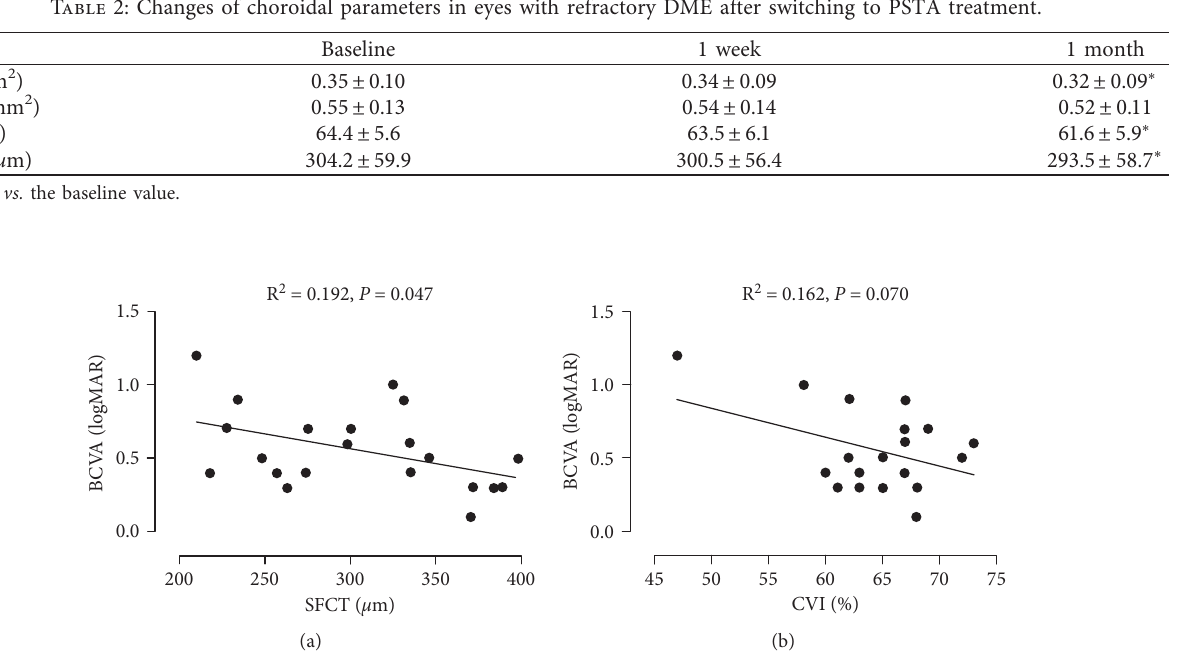
Figure 4: The linear regression analysis between the choroidal parameters and the final BCVA after switching to PSTA